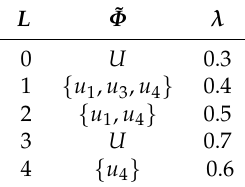
Table 4. Tabular representation of the hybrid structure ˜ Φ λ